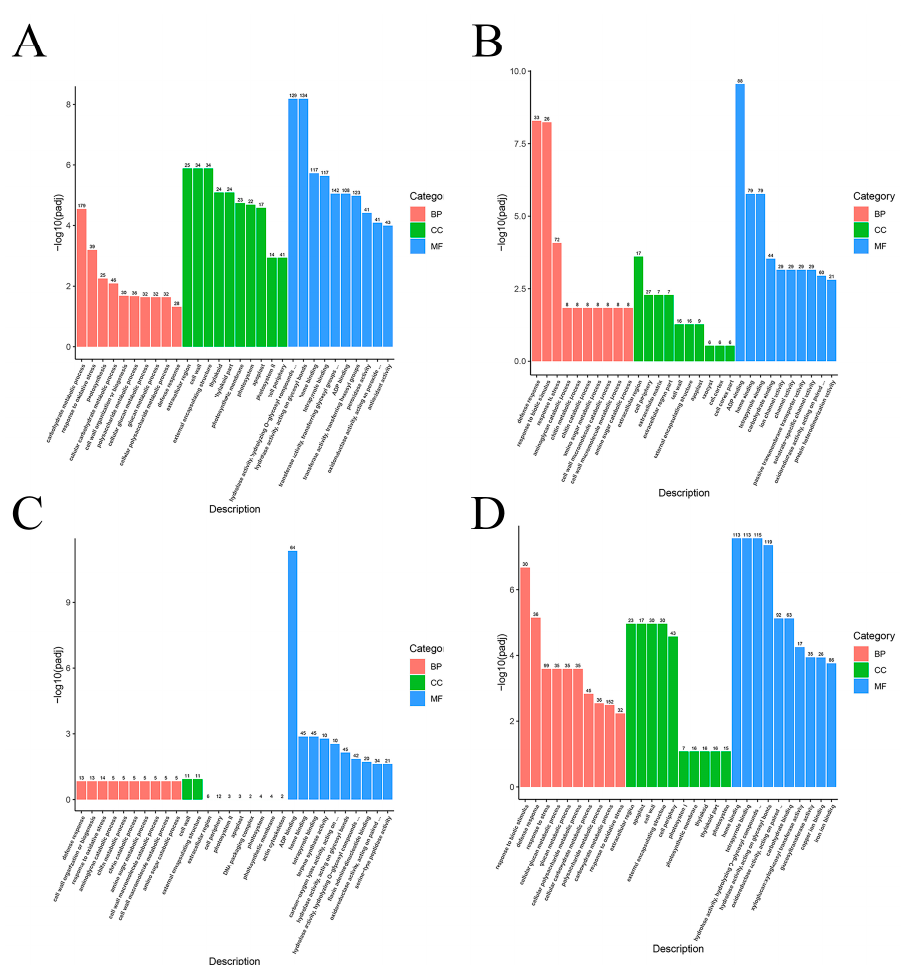
Figure 7. GO term enrichment analysis of DEGs in response to different stress treatments. ( A ) CK vs. CK-D; ( B ) LA vs. CK; ( C ) LA-D vs. CK-D; ( D ) LA-D vs. LA. The x-axis indicates the GO classifications, and the Y-axis indicates the number of genes in each classification. The top 30 GO terms with the most significant enrichment level are displayed in the order of p -value from small to large.